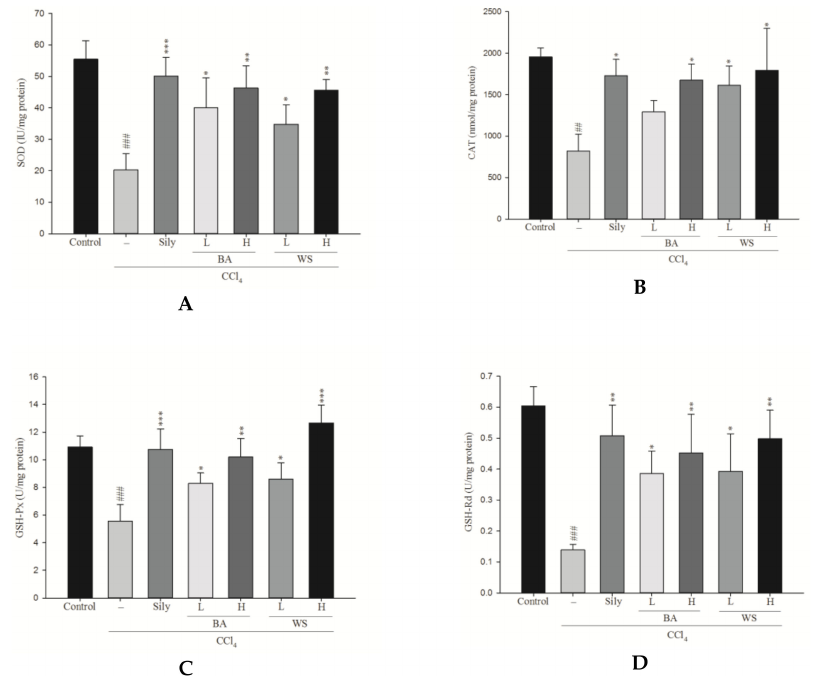
Figure 6. Effect of different fractions of black garlic and silymarin on hepatic ( A ) SOD ( B ) CAT ( C ) GSH-Px ( D ) GSH-Rd activities in mice treated with CCl 4 . Each value represents as mean ± S.E.M. ( n = 10). ## p < 0.01, ### p < 0.001 as compared with the control group. * p < 0.05, ** p < 0.01, *** p < 0.001 as compared with the CCl 4 group (one-way ANOVA followed by Scheffe’s multiple range